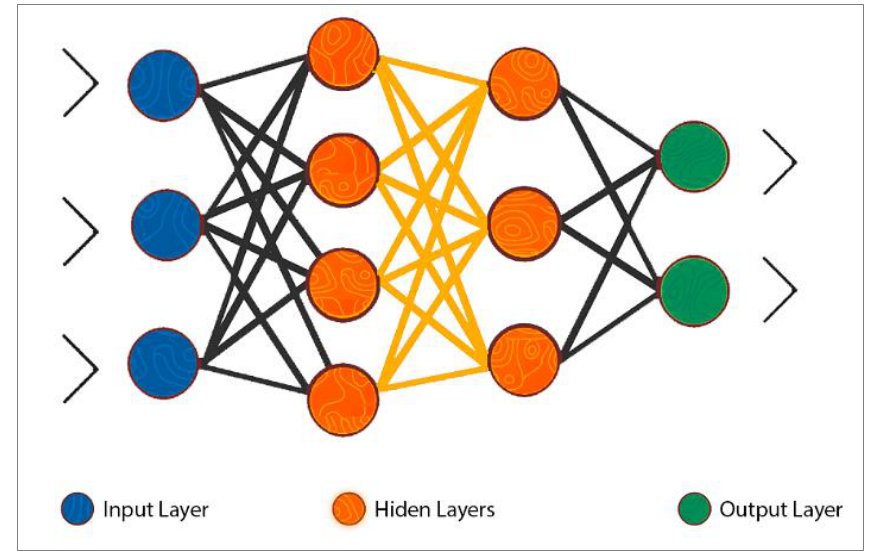
Figure 1. Diagram of the proposed